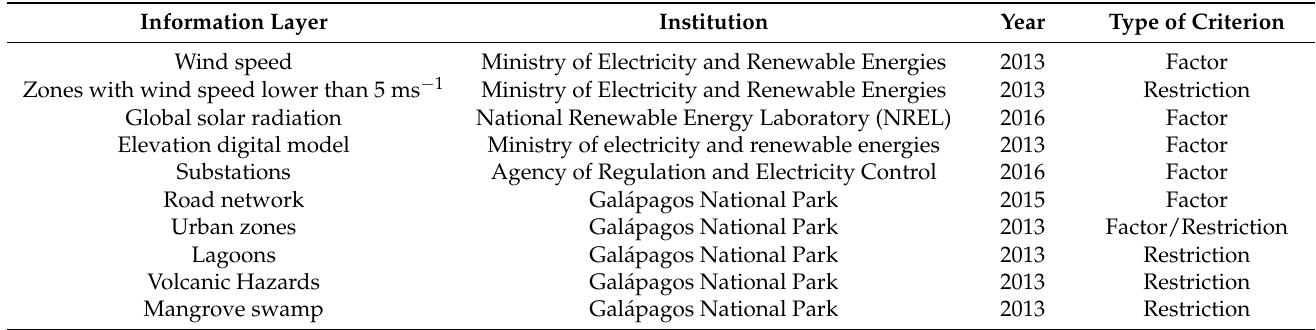
Table 1. Criteria selection.